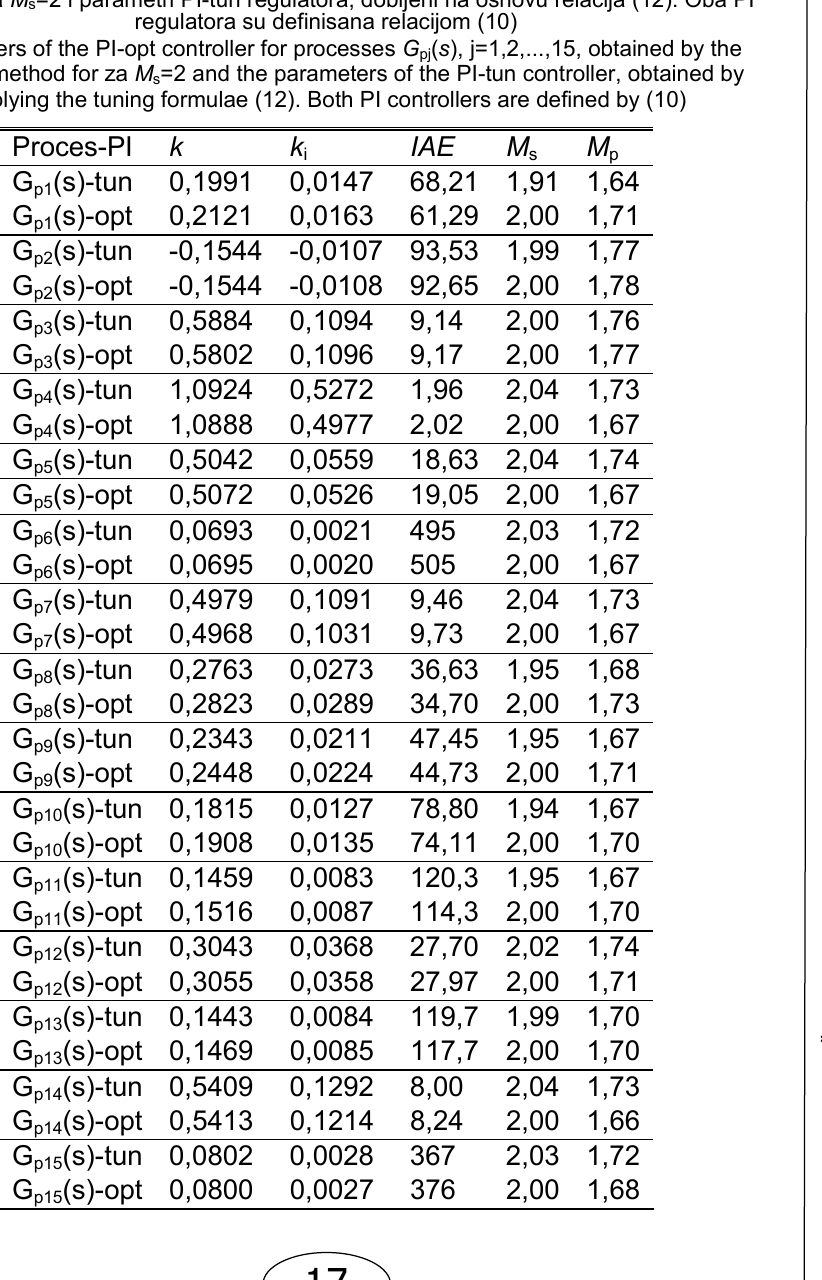
Parametri PI-opt regulatora za procese G pj (s), j=1,2,...,15, dobijeni primjenom metode max( J c ) za M s =2 i parametri PI-tun regulatora, dobijeni na osnovu relacija (12). Oba PI regulatora su definisana relacijom (10) Parameters of the PI-opt controller for processes G pj ( s ), j=1,2,...,15, obtained by the max(